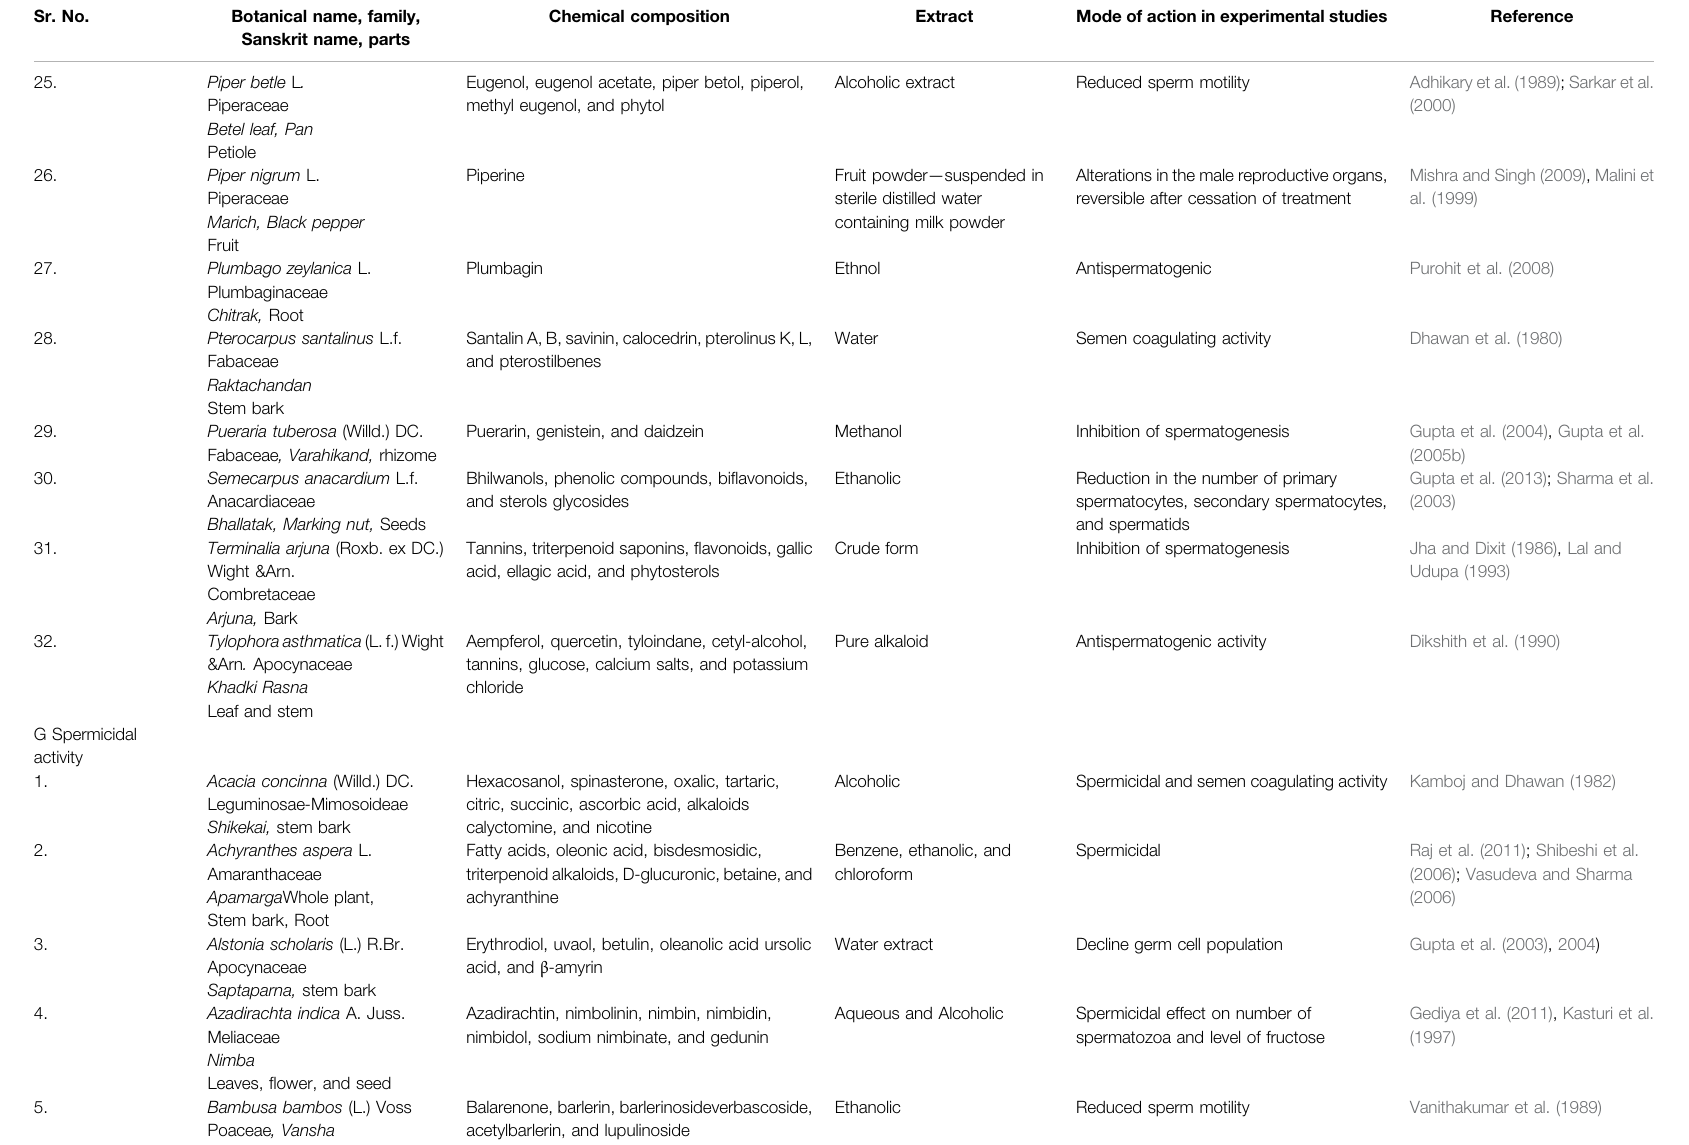
TABLE 2 | ( Continued ) Medicinal plants and their phyotoconstituents validated for various female/male contraceptive activities. Different contraceptive activities studied on medicinal plants could be categorized as follows. Female contraceptive activities: (2A) anti-implantation activity, (2B) aborti fi cation, (2C) antifertility, (2D) antiovulatory, and (2E) antiestrogenic activity. Male contraceptive activities: (2F) antispermatogenic, (2G) spermicidal, and (2H) antiandrogenic